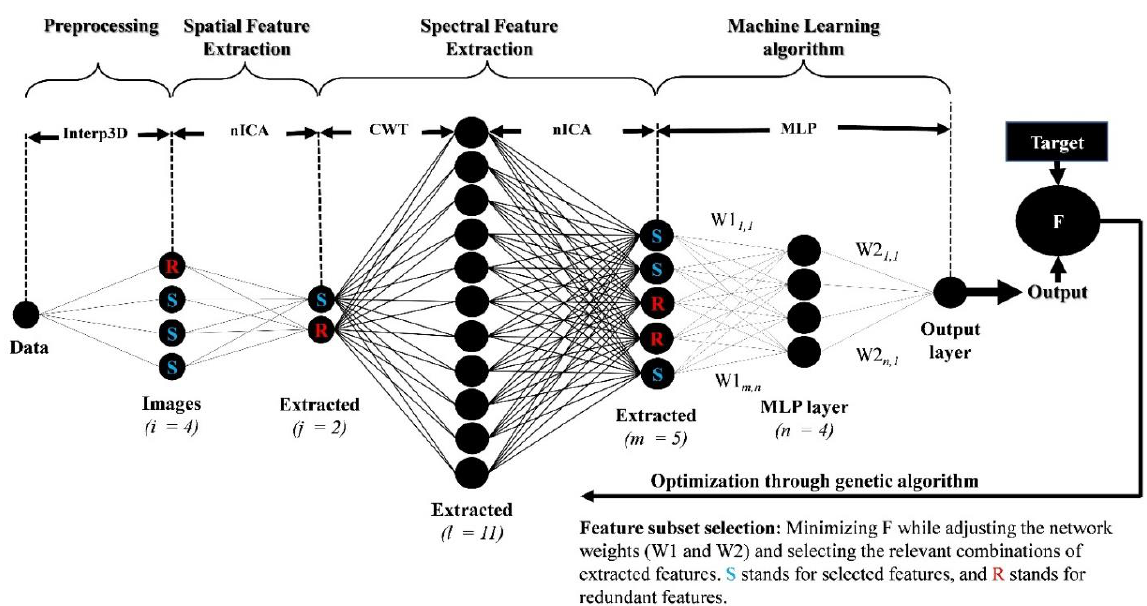
Figure 4. Schematic view of spectral feature subset selection for predictive modeling. The algorithm consists of four main sub-routines like the SRL algorithm, except that the MLP is integrated with NSGA-II to adjust the network weights and the selection of inputs simultaneously.